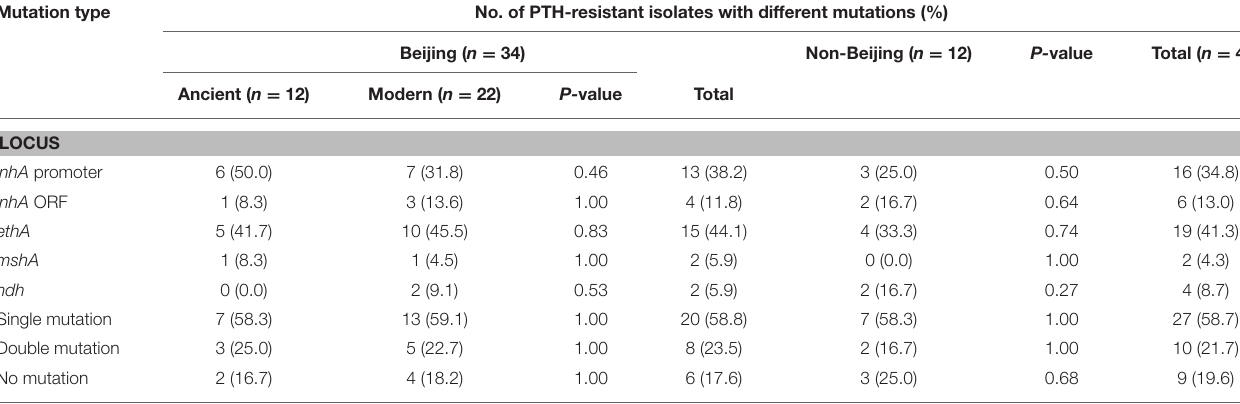
TABLE 7 | Distribution of different mutations conferring PTH resistance among Beijing and non-Beijing genotypes. Mutation type No. of PTH-resistant isolates with different mutations